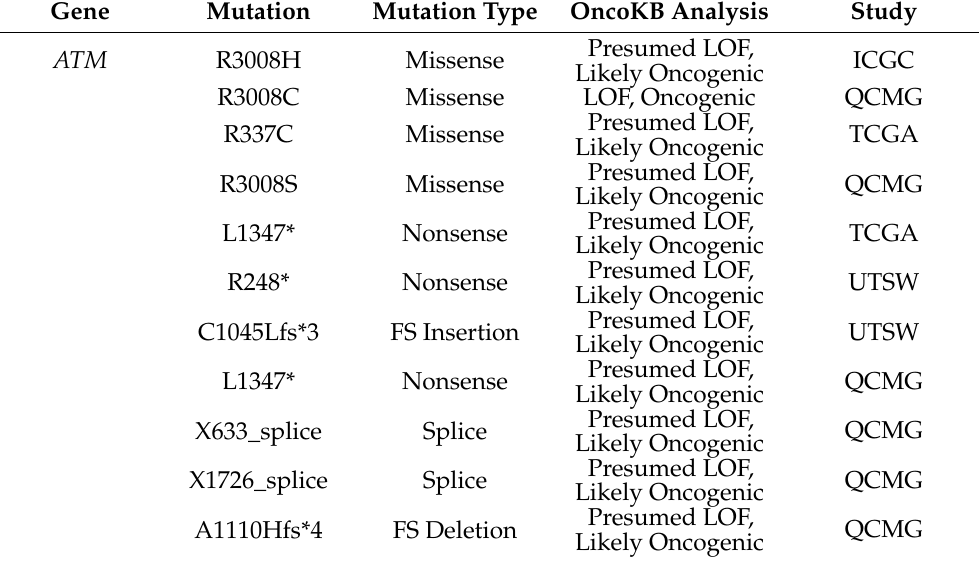
Table 2. Specific mutations to ATM , BRCA1 , BRCA2 , and PALB2 mutations in publicly available genomic datasets of PDAC